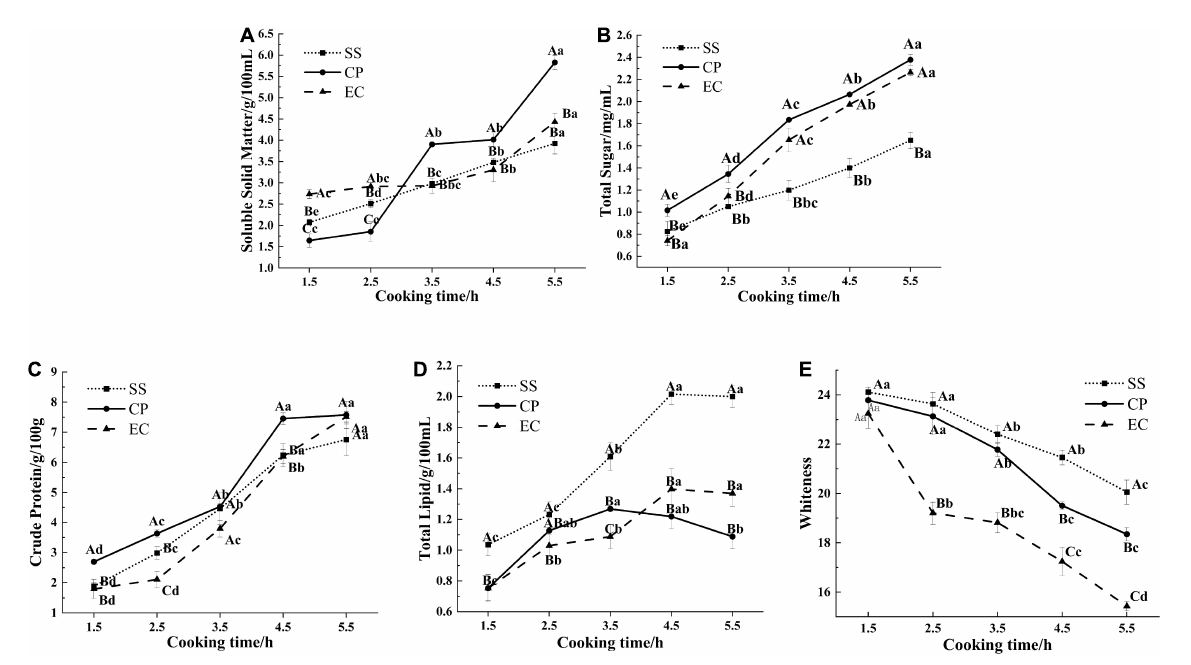
FIGURE1 Effect of cooking mode on soluble solid matters content (A) , total sugars content (B) , crude protein content (C) , total lipids content (D) and whiteness (E) of Clitocybe squamulose chicken soup. SS, Clitocybe squamulose chicken soup prepared in stainless-steel pot mode; CP, Clitocybe squamulose chicken soup prepared in ceramic pot mode; EC, Clitocybe squamulose chicken soup prepared in electrical ceramic stewpot mode. The uppercase letters show differences between cooking modes per time point, and lowercase letters show differences during cooking time per cooking